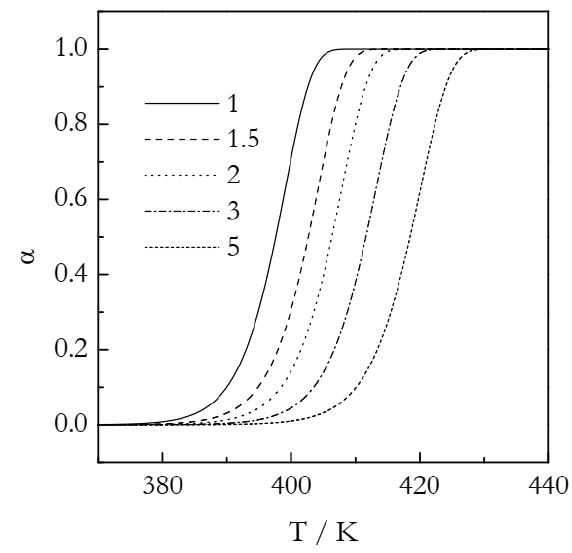
Figure 1. Simulated kinetic curves for the A3 process. Numbers by the lines are heating rates in K min − 1 .